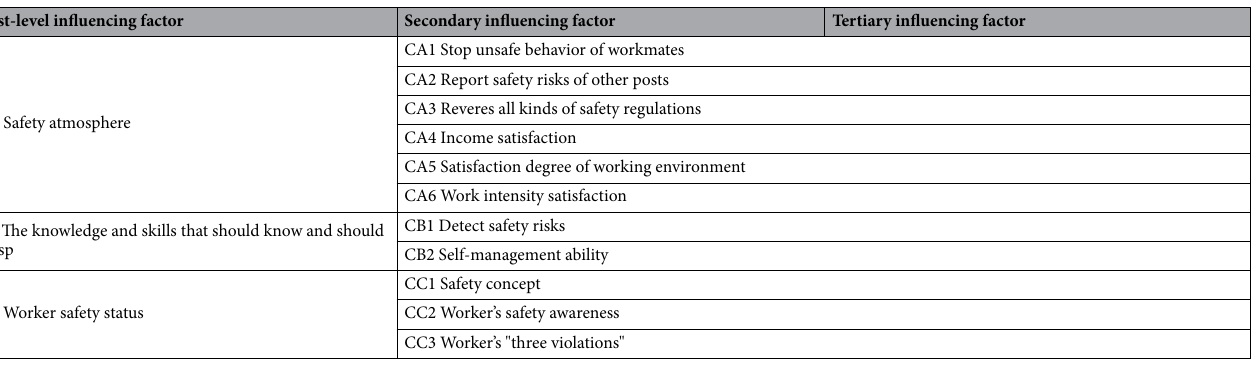
Table 2. List of indicators for enterprise safety risk